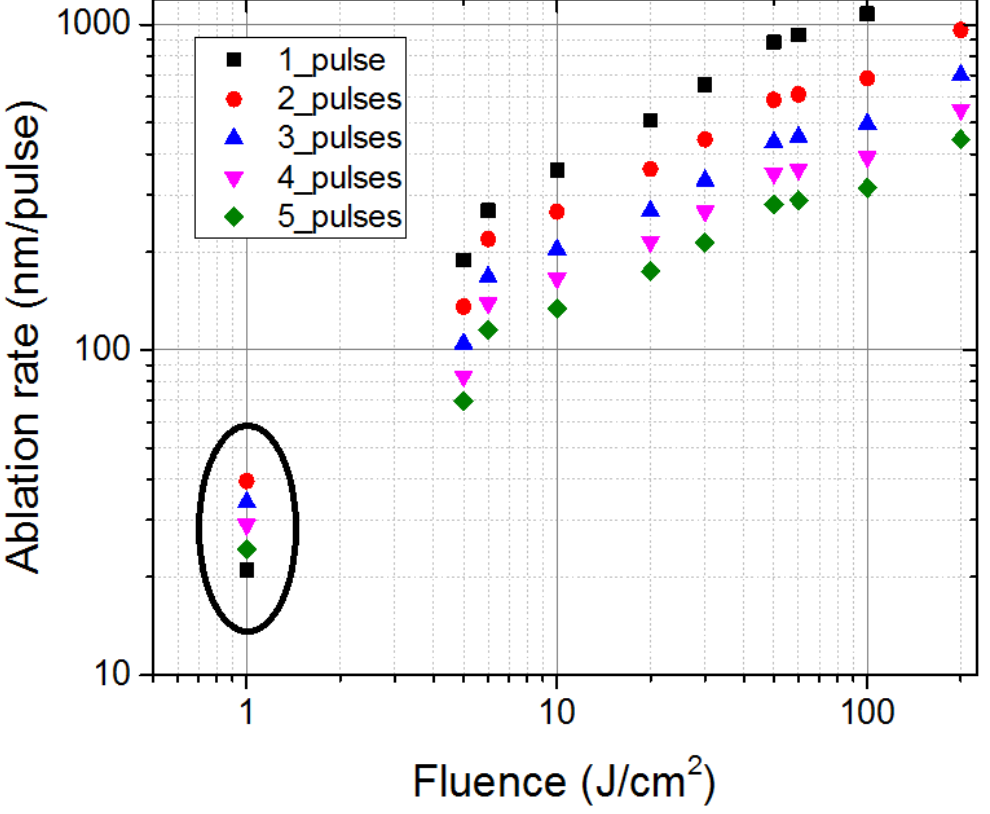
Figure 7. The ablation rate as a function of fluence at different pulse numbers with t sep = 1.5 ps ( 2 repetition